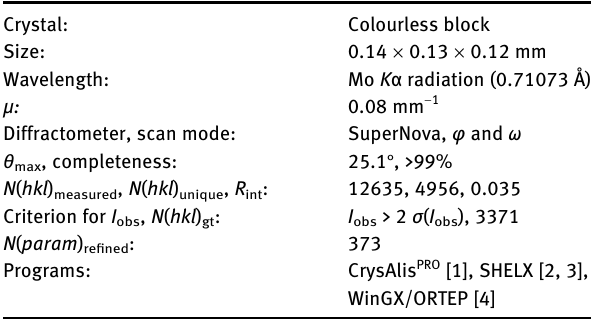
Table  : Data collection and